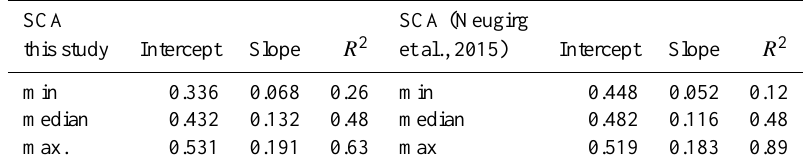
Table 3. Results from the statistical based erosion model for one month. SCA SCA